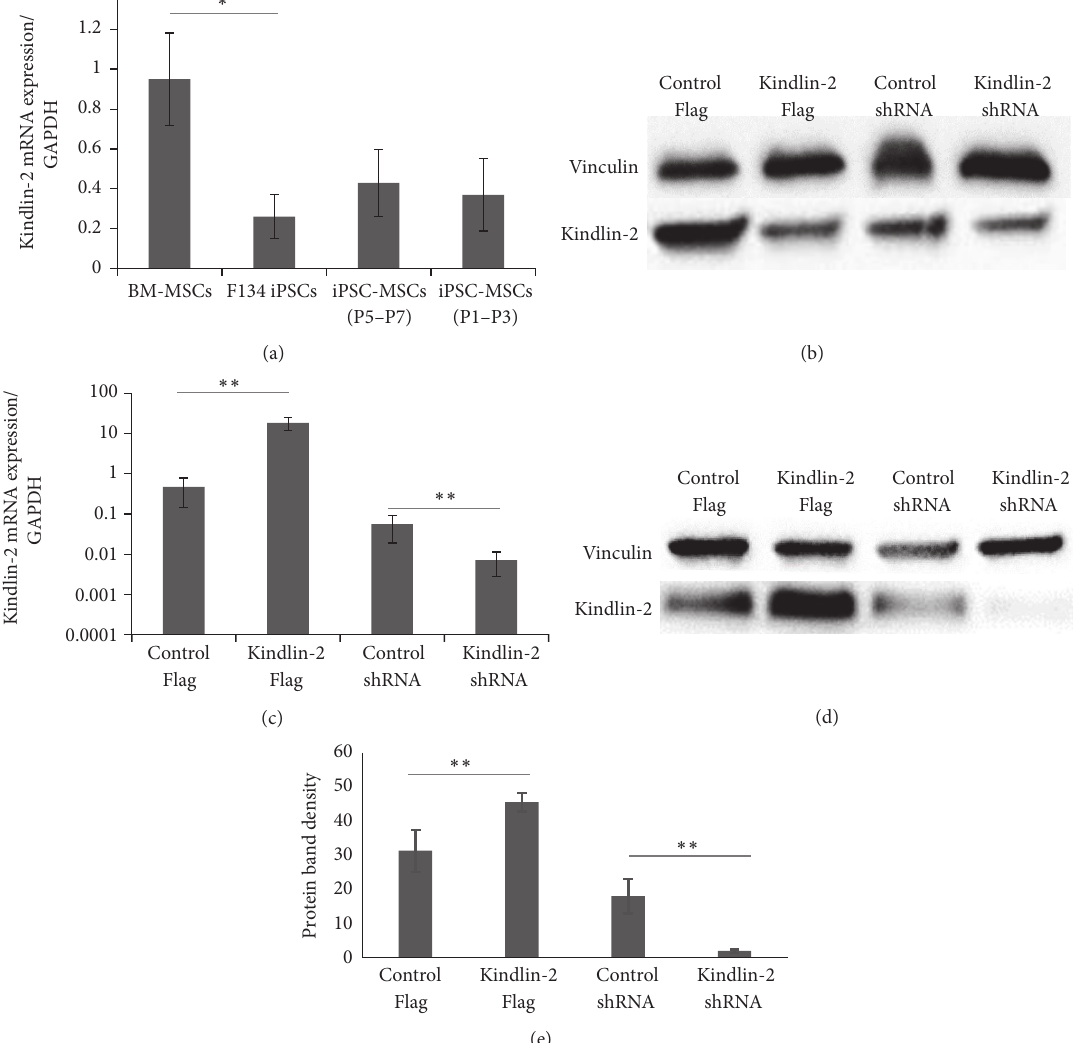
Figure 1: Kindlin-2 expression pattern, overexpression/knockdown, and targets. (a) mRNA expression levels of Kindlin-2 in F134 iPSCs and different passages of iPSC-MSCs indicated significant differences with BM-MSCs; total proteins were extracted from all cell types. (b) Western blotting was performed using an anti-Kindlin-2 monoclonal antibody. (c) Real-time qPCR was performed to quantify mRNA levels of Kindlin-2 in iPSC-MSCs (passages 1–3) with Kindlin-2 overexpression or knockdown. (d, e) Western blot analysis (d) and densitometry (e) performed with ImageJ software were performed and indicate efficient overexpression and knockdown. Data represents the mean expression values normalized to the housekeeping gene GAPDH. ∗ Significance difference 𝑝 ≤ 0.05 . ∗∗ Significance difference 𝑝 ≤ 0.01 .